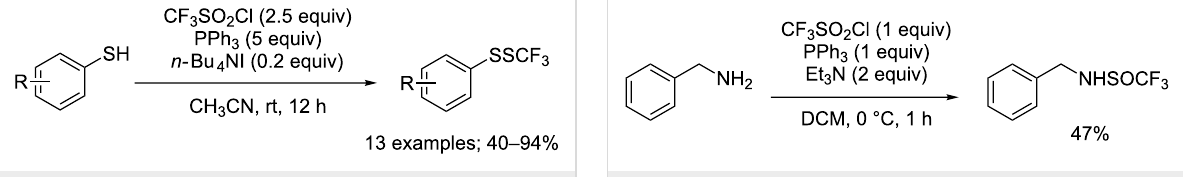
Scheme 36: PPh 3 / n- Bu 4 NI mediated trifluoromethylsulfenylation of thiophenol